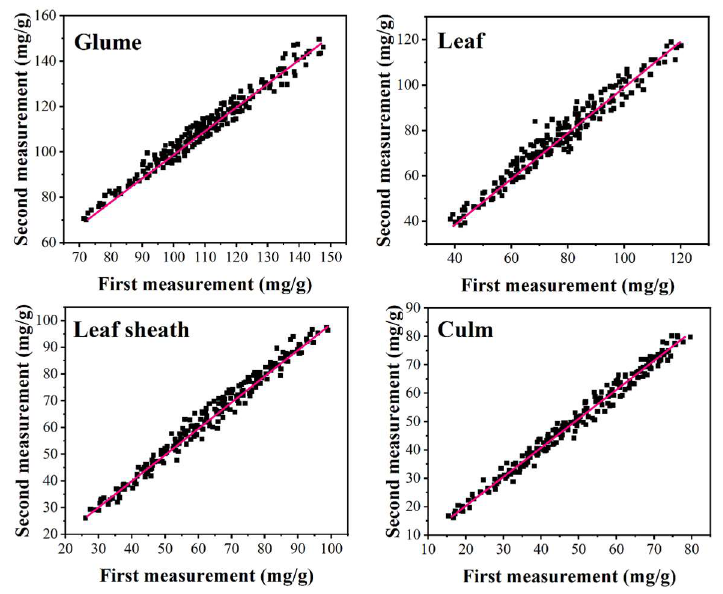
Figure 5. Silicon determination of 200 samples of glume, leaf, leaf sheath and culm.